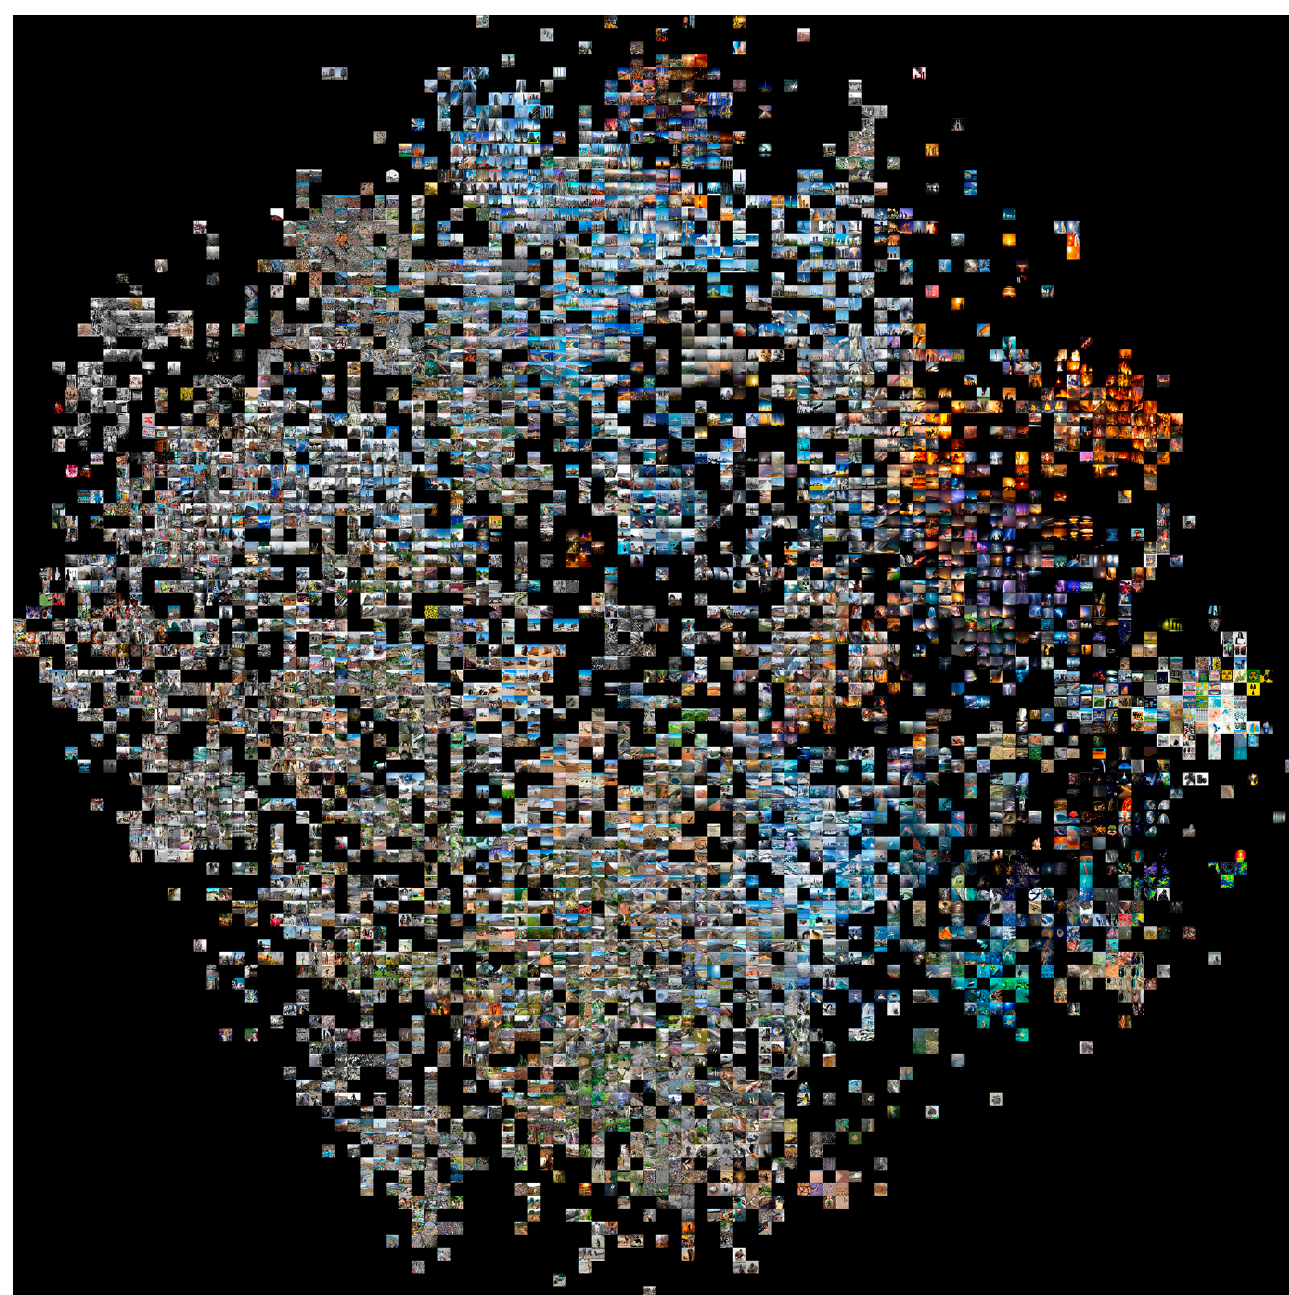
Figure 17 . Digital image containing 10,000 photographs of climate change, ordered using the ResNet-50 convolutional neural network (2 × 2 m). © Pilar Rosado.